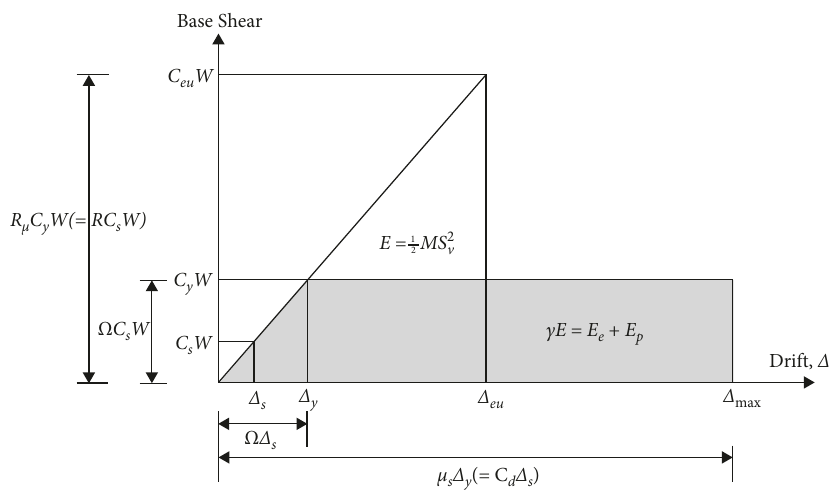
Figure 1: Structural idealized response and energy balance concept Table 1: Ductility reduction factor and the corresponding structural period range. Period range